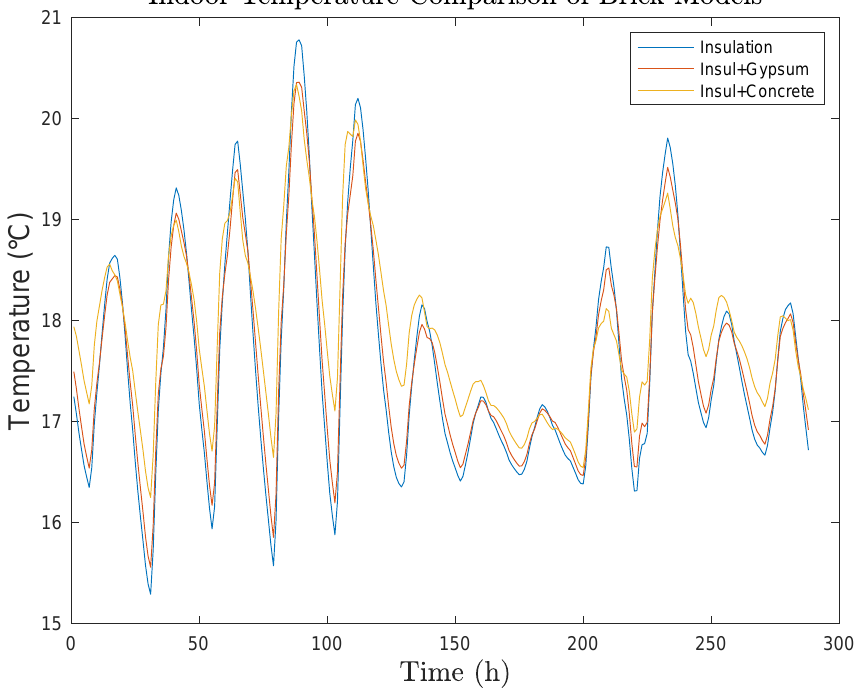
Figure A2. Comparison of the indoor temperature for the three different internal structures of the